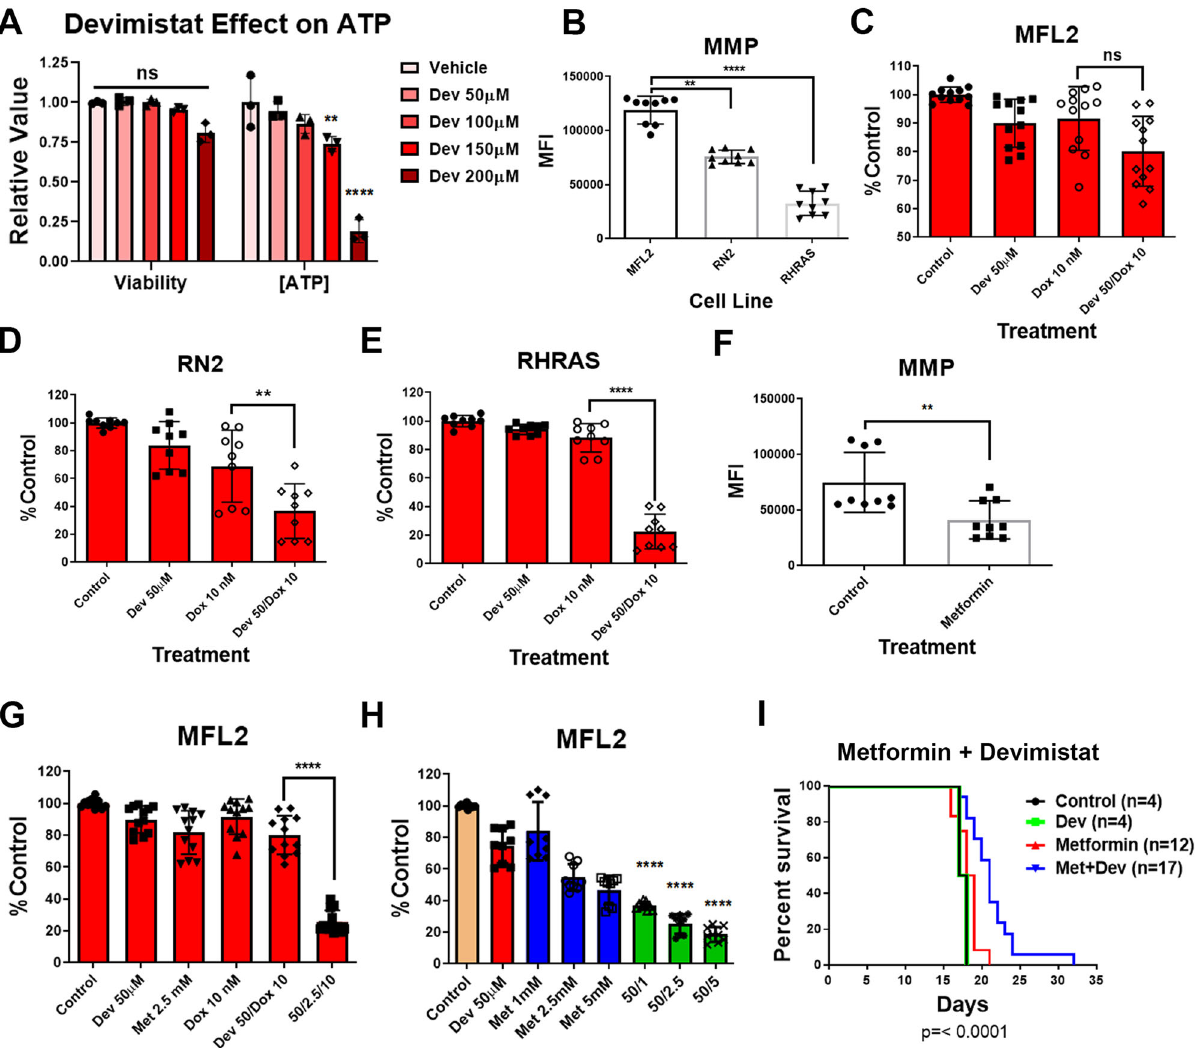
Fig. 3 Activity of devimistat depends on baseline MMP. A ATP concentrations. MFL2 cells were incubated with the indicated amount of devimistat for 6 h and assayed for viability using trypan blue exclusion and ATP content using Cell Titer Glo. Means from three independent experiments are shown. B TMRM staining. Three genetically de fi ned murine AML cell lines were stained with TMRM and assessed by fl ow cytometry. Median fl uorescence intensity of TMRM stained cells from three independent experiments were quantitated and plotted. C – E Three genetically de fi ned murine AML cell lines were exposed to the indicated chemotherapy, devimistat (CPI-613) or both for 72 h and assessed for viability. Shown are the means of at least three biological replicates each done in triplicate. F MFL2 cells untreated (control) or treated with 2.5 mM metformin for 24 h were stained with TMRM and assessed by fl ow cytometry. Median fl uorescence intensity of TMRM stained cells from three independent experiments, each in triplicate were quantitated and plotted. G MFL2 cells were exposed to the indicated chemotherapy, devimistat (CPI-613), metformin or combinations for 72 h and assessed for viability. Shown are the means of four biological replicates each done in triplicate. H MFL2 cells were exposed to the indicated doses of devimistat (CPI- 613), metformin or the combination for 72 h and assessed for viability. Shown are the means of three biological replicates each done in triplicate. I Survival of syngeneic C57Bl/6 mice injected with 1 × 10 6 MFL2 cells and treated with PBS (Control), metformin, or devimistat or the combination. P value calculated by log-rank test. Viability data for panel C were derived from four independent experiments each done in triplicate. All other viability data were derived from three independent experiments each done in triplicate. ** P < 0.01, **** P < 0.001. All error bars represent the standard deviation around the